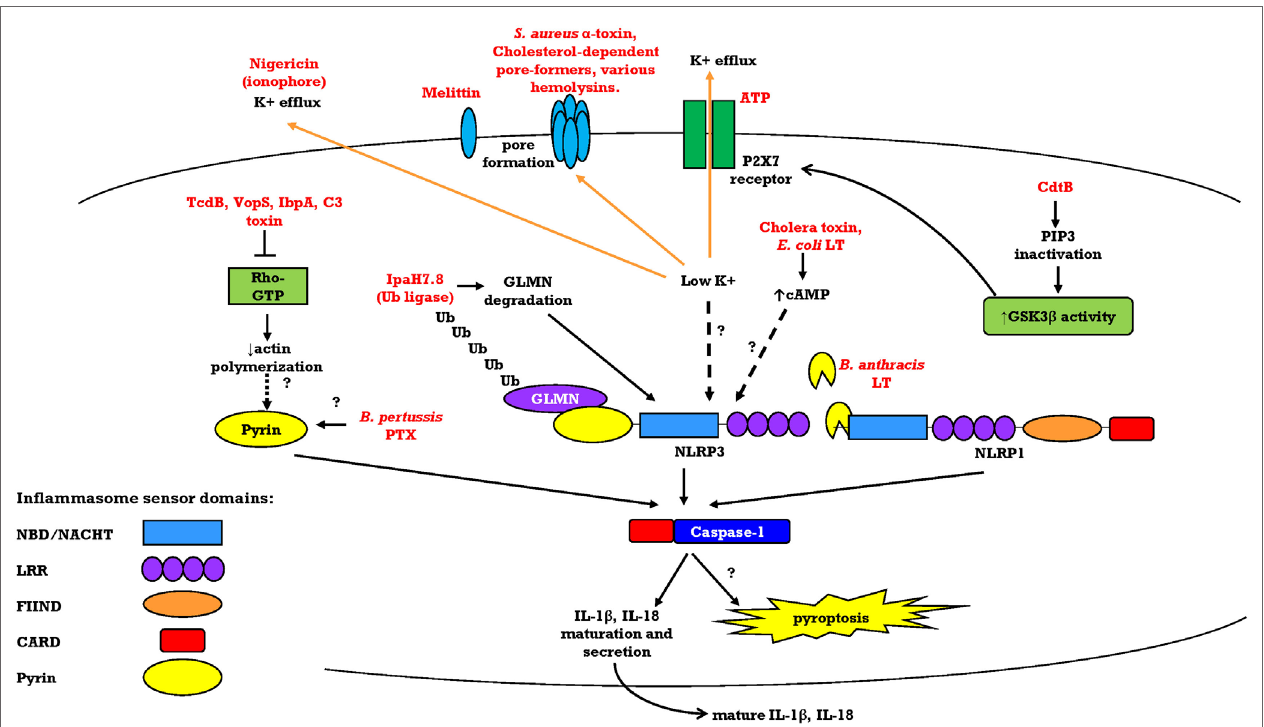
FiGURe 1 | Overview of mechanisms of toxin-induced activation of the Pyrin, NLRP3, and rodent NLRP1 inflammasomes . Bacterial exotoxins can activate the inflammasome sensors through diverse direct or indirect mechanisms. After inflammasome sensor activation, these different pathways converge on caspase-1 recruitment to the inflammasome platform and autoproteolytic activation. Caspase-1 cleaves its substrates pro-IL-1 β and pro-IL-18 to their mature forms for secretion. Caspase-1 activation is also accompanied by pyroptosis through an unknown